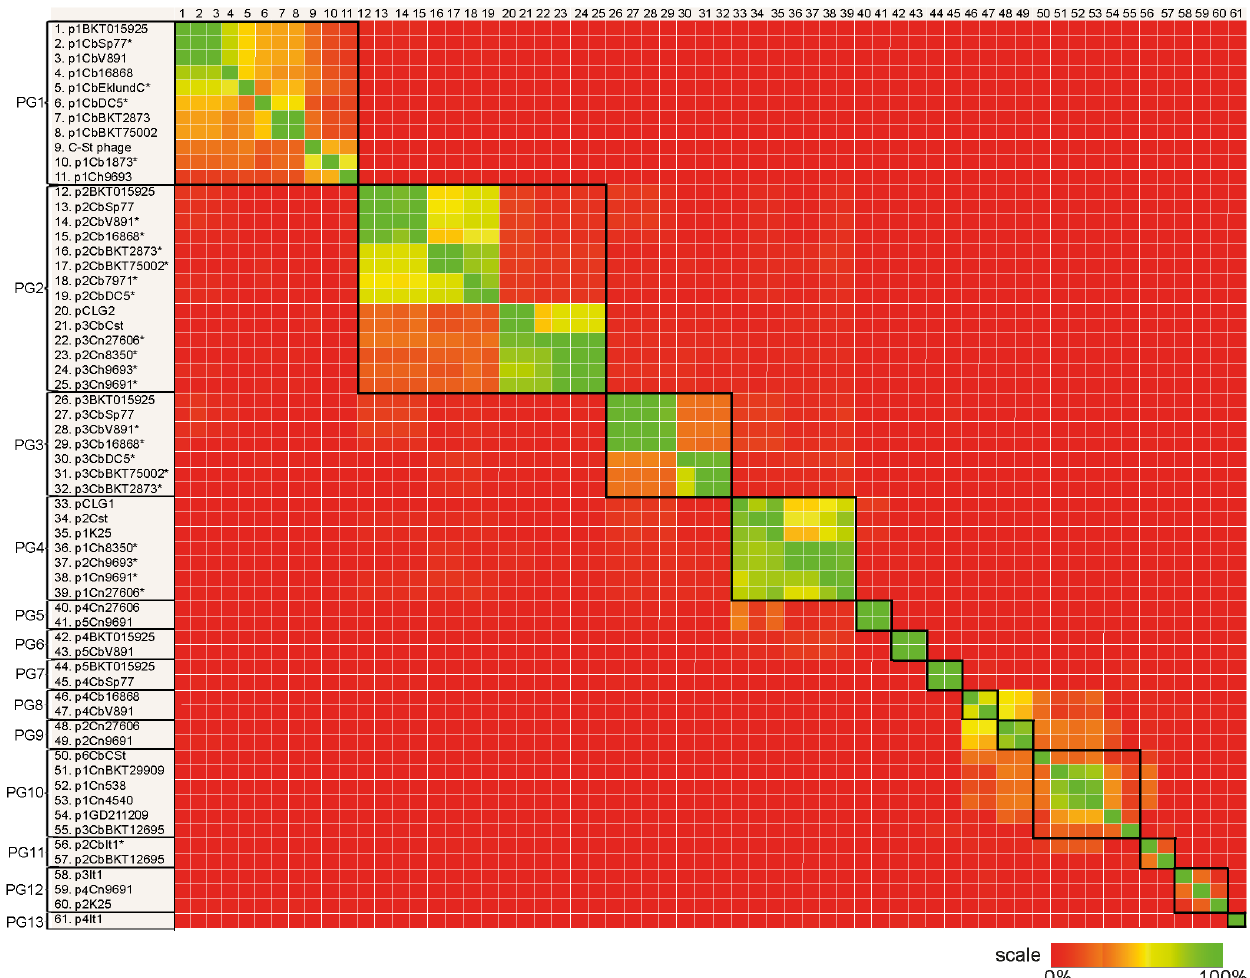
Figure 2. Comparative analysis of C.novyisensulato plasmids. A heat-plot of the relative amount of shared genetic material between plasmids (40% normalized BLASTN score threshold). Thirteen plasmid groups (PG1–PG13), framed by black squares, were identified from these results and from analysis of plasmid replication and partitioning genes. Some of the plasmids in lineage I strains (PG1–PG3) shared several IS elements, and this resulted in an apparent increase in the background level of shared genetic content between otherwise dissimilar plasmids within this lineage. Uncompleted plasmids are marked with a star.